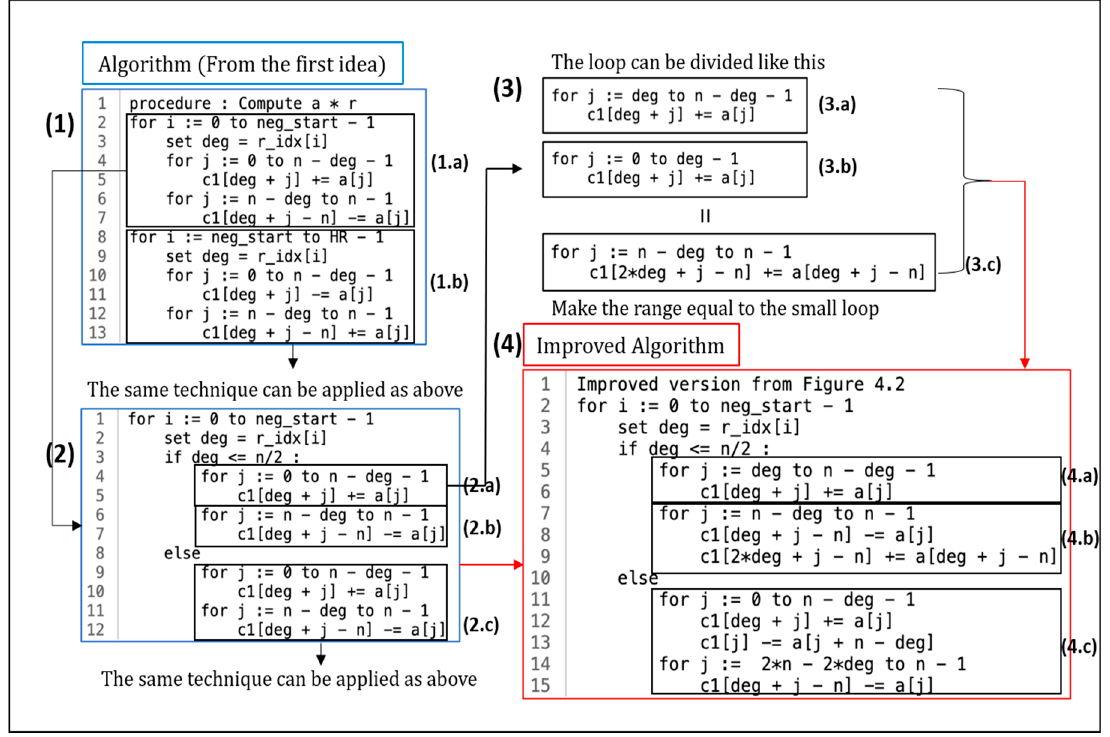
Figure 3. The second proposed technique: “Algorithm (From the first idea)” refers to the result obtained by applying the first technique, and the result of applying the second is described in the “Improved Algorithm” part in the figure.